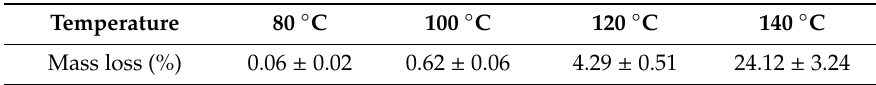
Table 2. The thermogravimetric analysis (TGA) data showing the temperature and the mass loss at that temperature. Mass loss was measured over four-hour periods.